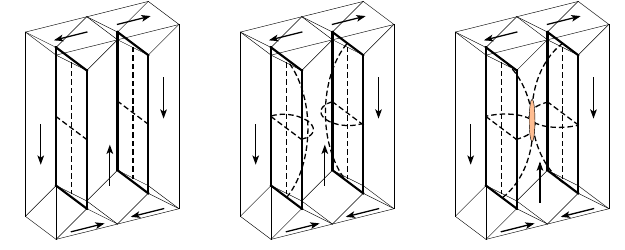
Figure 13. Three-dimensional representation of a single grain and stripe-to-channel reconnection. The left image depicts the unmag- netized stripe domains within a grain. A larger grain would contain additional domains, all of which the same width. The middle image depicts initial permeability. The right image depicts the start of re- connection at the domain wall midpoint. A fixed amount of domain wall displacement is required, regardless of the size of the grain. A larger grain would also have longer stripe domains and require less external field for a given amount of wall displacement, i.e., higher initial permeability. Higher initial permeability in combination with a fixed amount of wall displacement for reconnection implies lower coercivity. Thus increasing grain size leads directly to higher per- meability and lower